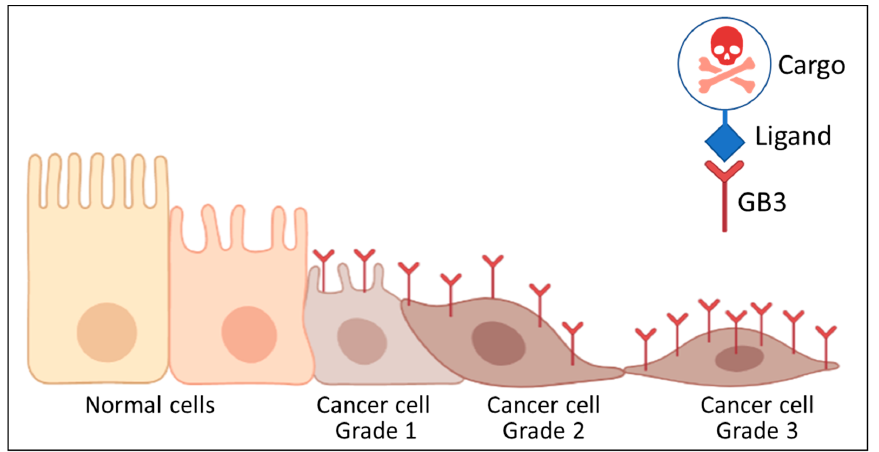
Figure 4. Schematic representation of the transformation process and different GB3 levels of expression. The GB3 is a possible receptor to target diagnostic or therapeutic solutions into malignant cells. Created with Biorender.com.